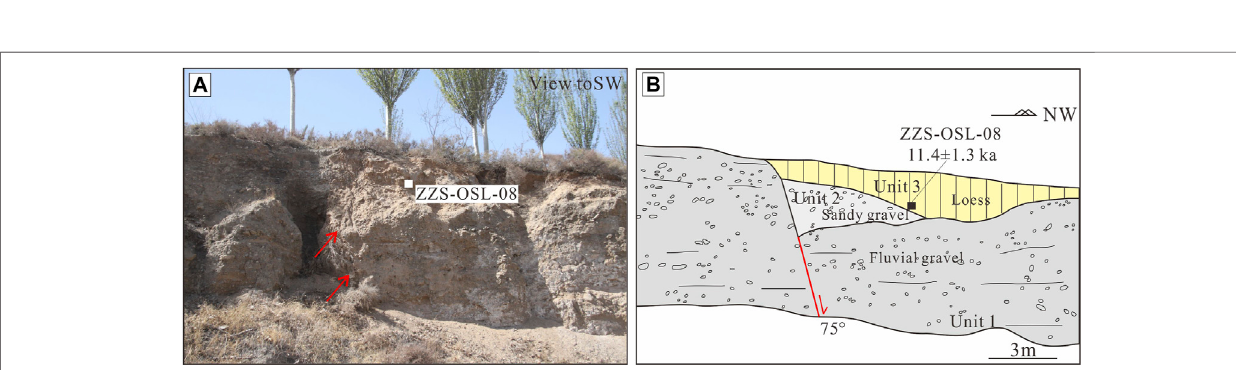
FIGURE6|(A) SatelliteimagefromGoogleEarth.Thelocationoffaultscarpsisindicatedbyredarrows (B) .Interpretedgeomorphicmapofthedistributionof fl uvial terraces, normal fault scarps and sampling positions at the Dongshanbei site. Four levels of river terraces are mapped according to their morphologic features and different heights above the channel in fi ll.